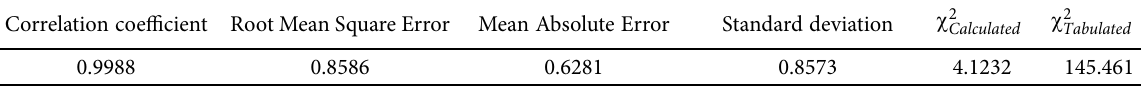
Table 7. Summary of output from ANN modelling for testing stage Correlation coefficient Root Mean Square